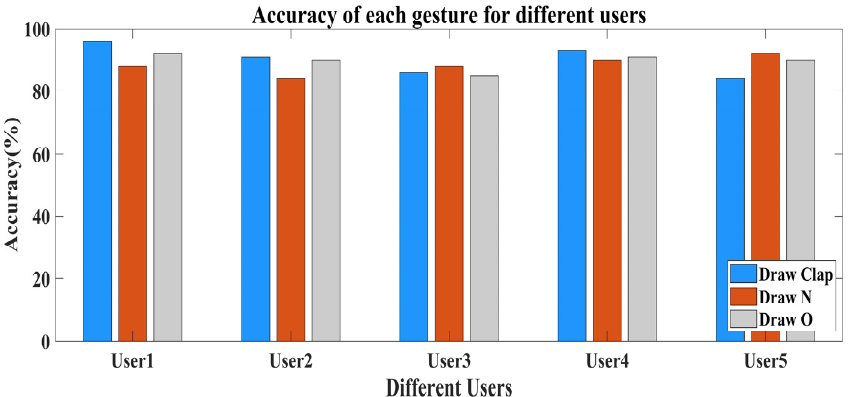
Figure 13. Comparison of gesture recognition accuracy for different users.